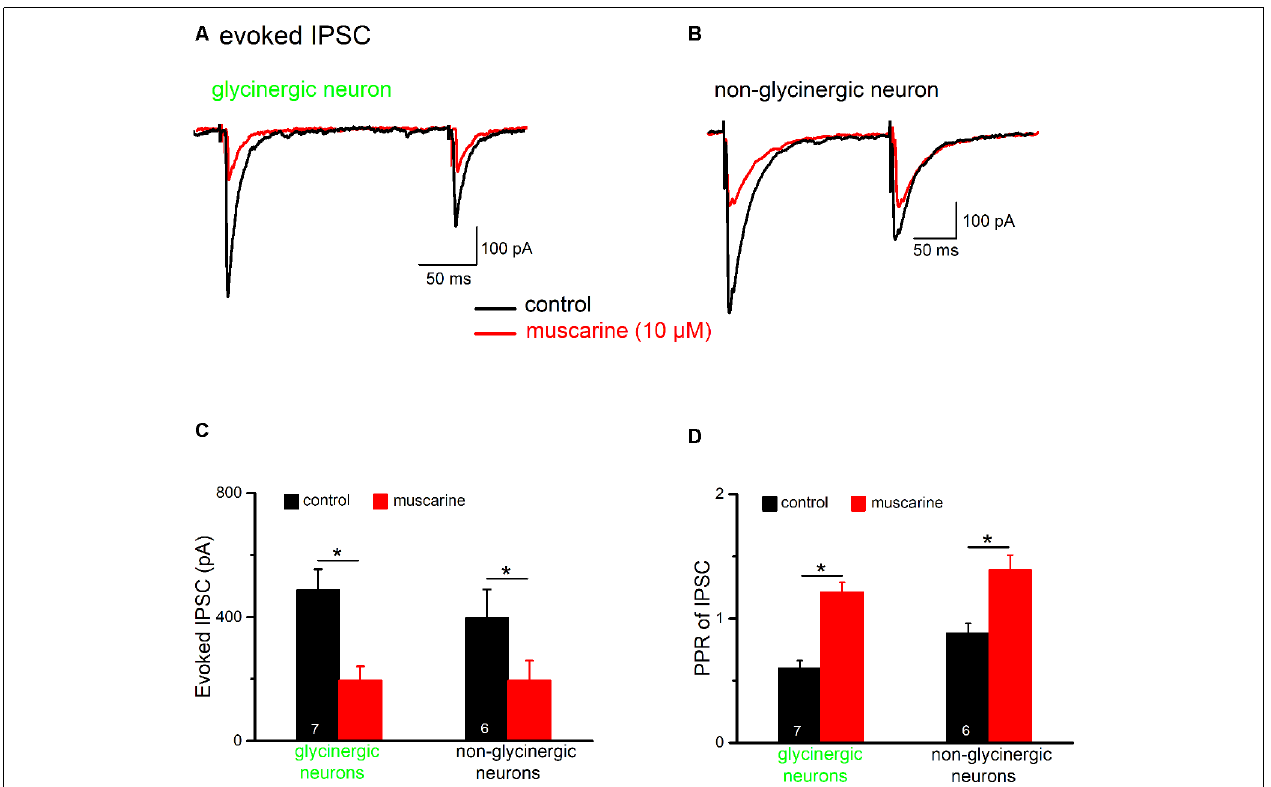
FIGURE 8 | Muscarine reduces inhibitory postsynaptic currents (IPSCs) in preBötC neurons. Voltage-clamp recordings of evoked IPSCs were made in the presence of kynurenic acid (2 mM). Cells were held at − 70 mV and IPSCs are shown as downward deflections due to the high chloride-containing internal solution. Traces in (A,B) are example traces from an EGFP-positive (“glycinergic”) and an EGFP-negative (“non-glycinergic”) neuron in the preBötC, respectively. Pairs of IPSCs were evoked by delivering two identical, electrical stimuli at half-maximal amplitude to the slice, 200 ms apart, using a nearby placed stimulating electrode. Note the decrease in peak IPSC amplitude in response to the 2nd stimulus compared to the 1st in control perfusate. Traces recorded before and after bath application of muscarine (10 µ M) are superimposed. The paired-pulse ratio (PPR) was determined by dividing the peak amplitude of 2nd IPSC by the peak amplitude of the 1st IPSC. A PPR < 1 indicates paired-pulse depression (PPD), while a PPR > 1 signifies paired-pulse facilitation (PPF). The muscarine-induced inhibition of 1st IPSC and the accompanying change in PPR were quantified, and group means values and SEM measured for these parameters in glycinergic and non-glycinergic neurons are shown in the histograms in (C,D) , respectively ( ∗ p <